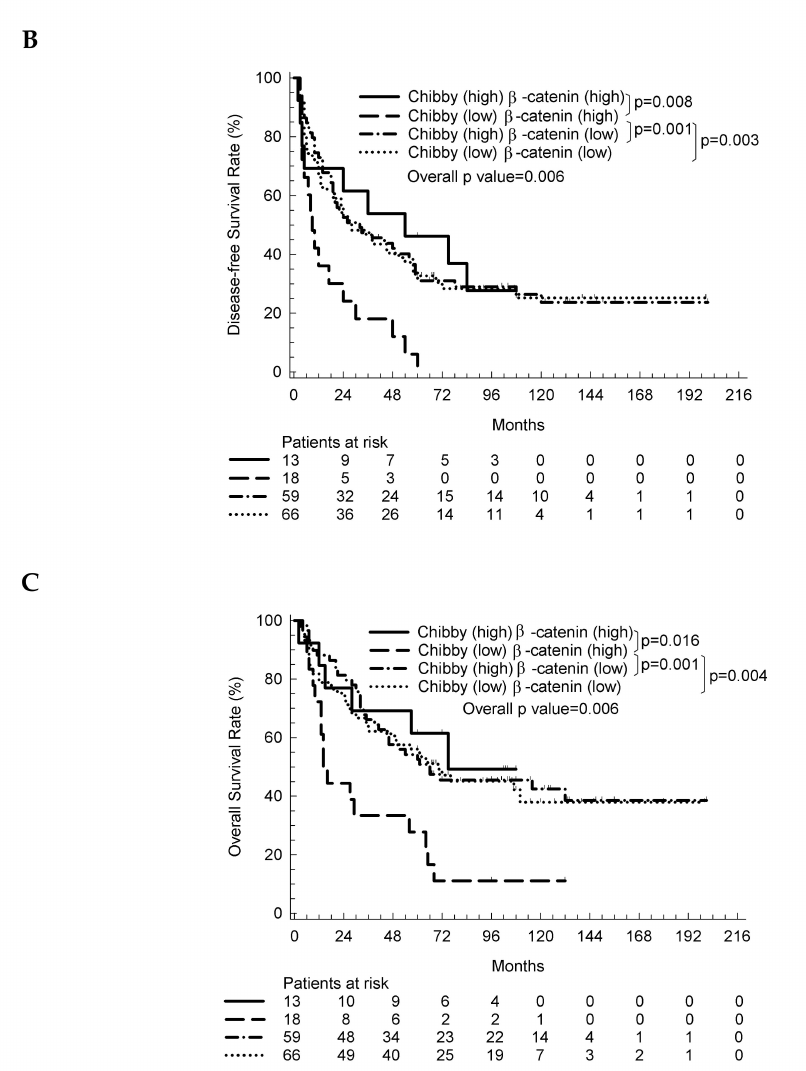
Figure 3. The high expression of nuclear β -catenin and low expression of nuclear Chibby in HCC tissue indicates poor disease-free survival and overall survival. ( A ) There are four nuclear expression types of β -catenin and Chibby in representative HCC cases which were examined by immunohistochemistry (original magnification, 400 × ), Scale bar, 100 µ m: Group 1: β -catenin (high) / Chibby (high), β -catenin and Chibby were expressed highly in cell nuclei concurrently; Group 2: β -catenin (high) / Chibby (low), β -catenin was highly expressed in cell nuclei, but Chibby was low expressed in cell nuclei; Group 3: β -catenin (low) / Chibby (high), β -catenin was low expressed in cell nuclei, but Chibby was highly expressed in cell nuclei; Group 4: β -catenin (low) / Chibby (low), concurrently, β -catenin and Chibby were low expressed in cell nuclei. “High” was defined as the average score of β -catenin- or Chibby-expressed unclear in five fields (400 × magnification) higher than the mean score of all samples; “low” was defined as the score lower than the mean score of all samples. Patients with high expression of nuclear β -catenin and low expression of nuclear Chibby displayed poor disease-free survival (B) and overall survival